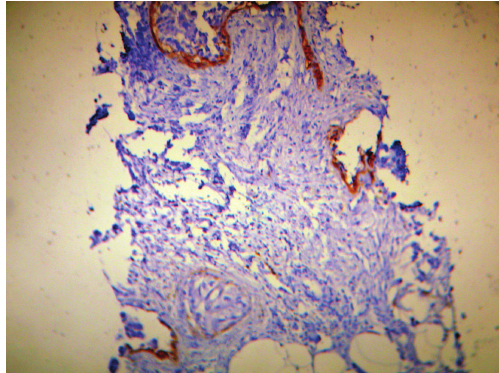
Figure 2: Nonneoplastic myoepithelial cells, whenever present, were used as built-in positive control.